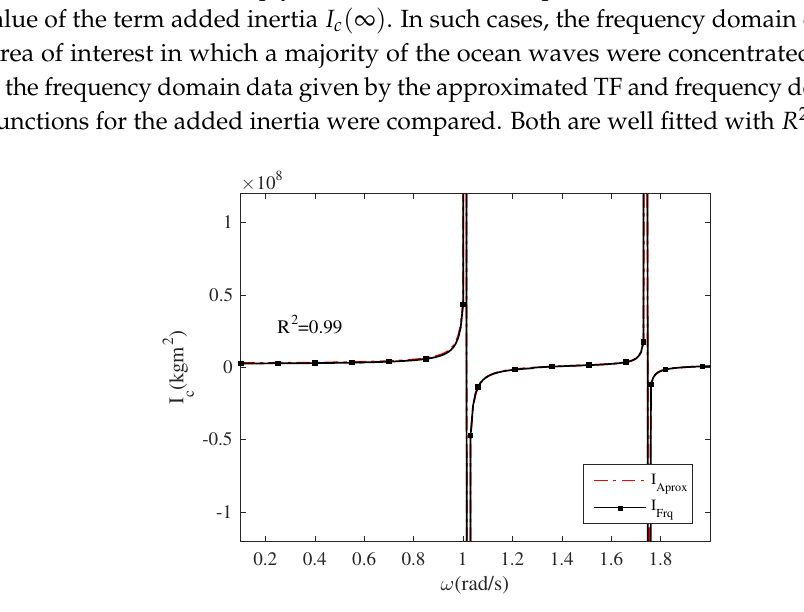
Figure 7. Added inertia ( I c ) vs. ω of the chamber side for frequency domain and transfer function approximation (dashed red line; frequency domain data, solid line; transfer function approximation